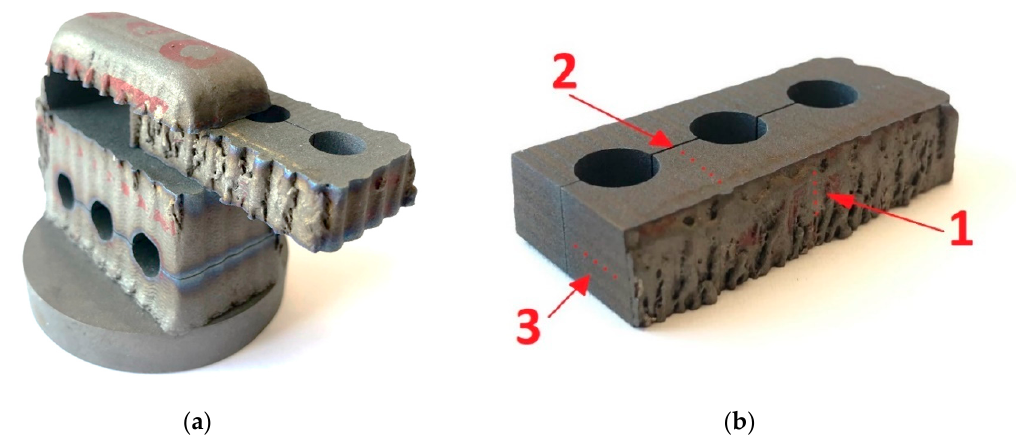
Figure 5. Cut-up sketch for the electric discharge sawing to determine mechanical properties ( a ), obtaining samples for compression testing in mutually perpendicular directions of track formation; ( b ) obtaining samples for measuring hardness in planes 1, 2, and 3.